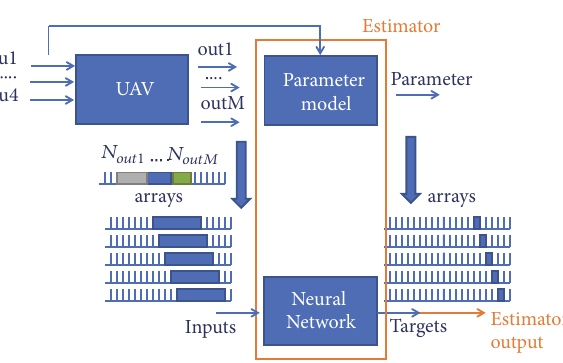
Figure 5: Neural estimator structure and